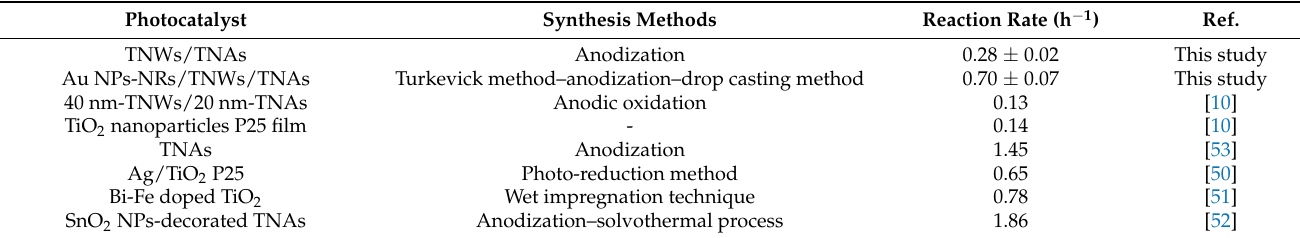
Table 2. The synthesis methods and photocatalytic reaction rate constants in the degradation of methylene of the selected TiO 2 -based nanophotocatalysts in this study and the literature.